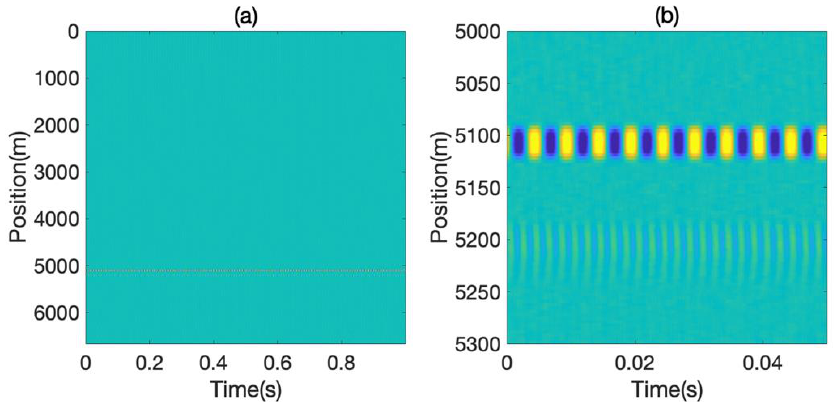
Figure 5. The phase before averaging ( 𝜑